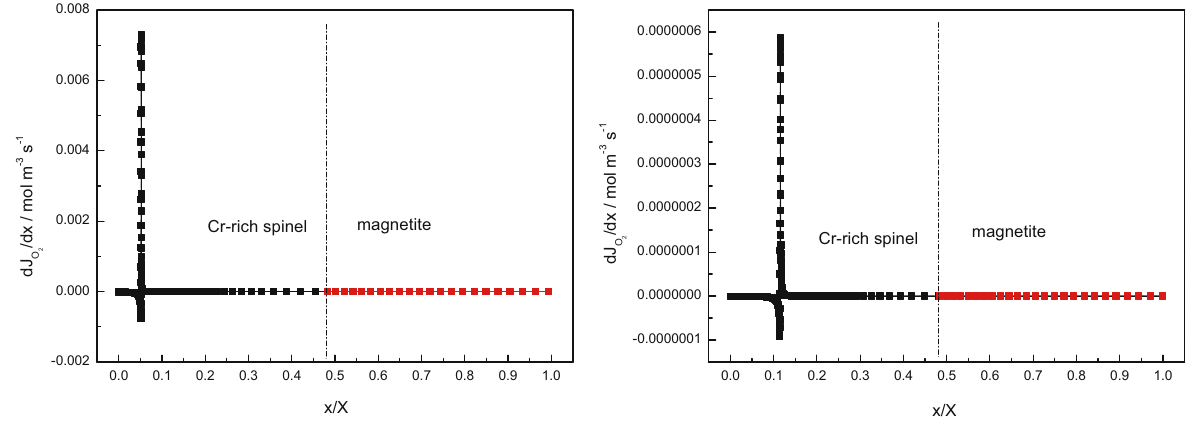
Figure 9: Divergence of flux of oxygen ion in oxide scale on HCM12A at 500°C ( left ) and 600°C ( right ) over normalized position.